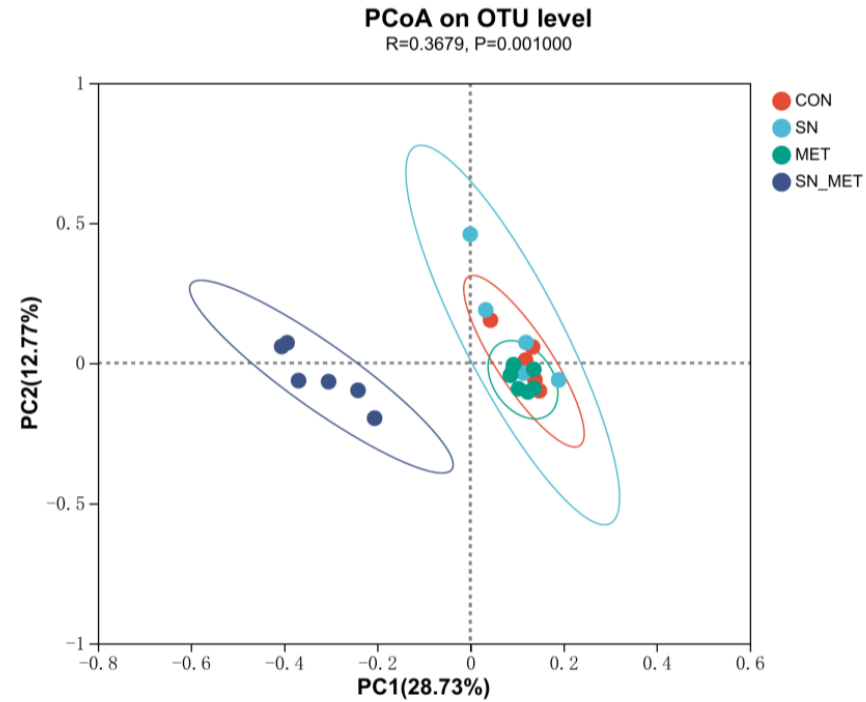
Figure 2. PCoA analysis of taxonomical classifications in the control (CON), 70 g/d sodium nitrate (SN), 15 g/d L-methionine (MET), and sodium nitrate group 70 g/d + L-methionine 15 g/d (SN+MET) groups.